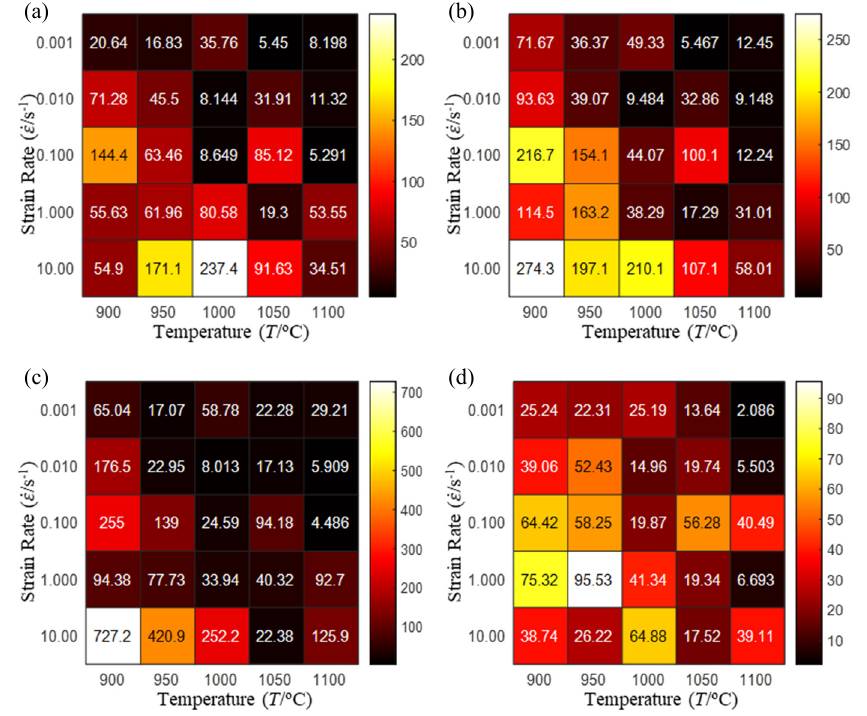
Figure 13. The distribution of the sum of absolute error between predicted flow stress and experimen- tal flow stress on temperature and strain rate: ( a ) Arrhenius constitutive model, ( b ) HS constitutive model, ( c ) linear model, and ( d ) quadratic model.